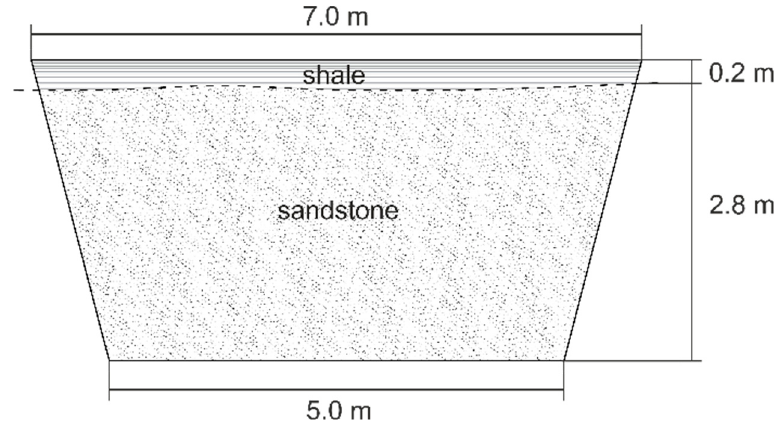
Figure 1. Scheme of the mining face cross-section, depicting the geologic structure and dimensions of the typical face over the considered panel. the typical face over the considered